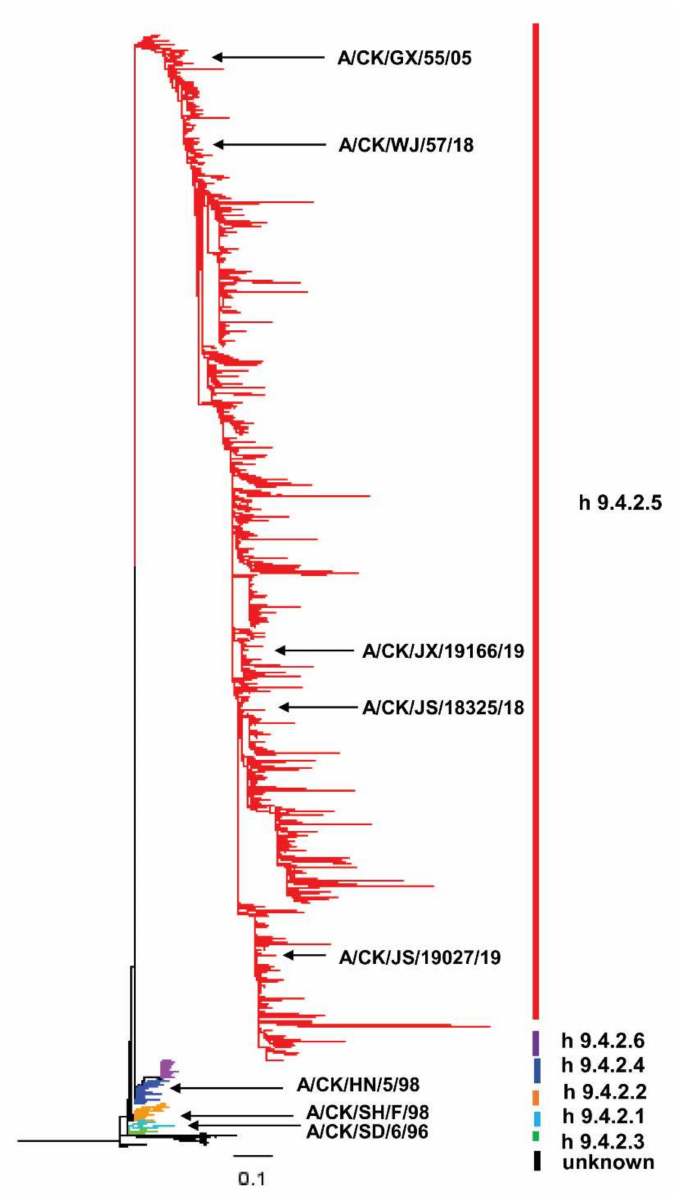
Figure 1. Phylogenetic evolutionary of HA protein of H9N2 AIV from 1994 to 2019 in China. Different epidemic branches were represented by different colors. CK: Chicken, GX: Guangxi, JX: Jiaxing, JS: Jiangsu, HN: Henan, SD: Shandong, WJ: Wujin, SH: